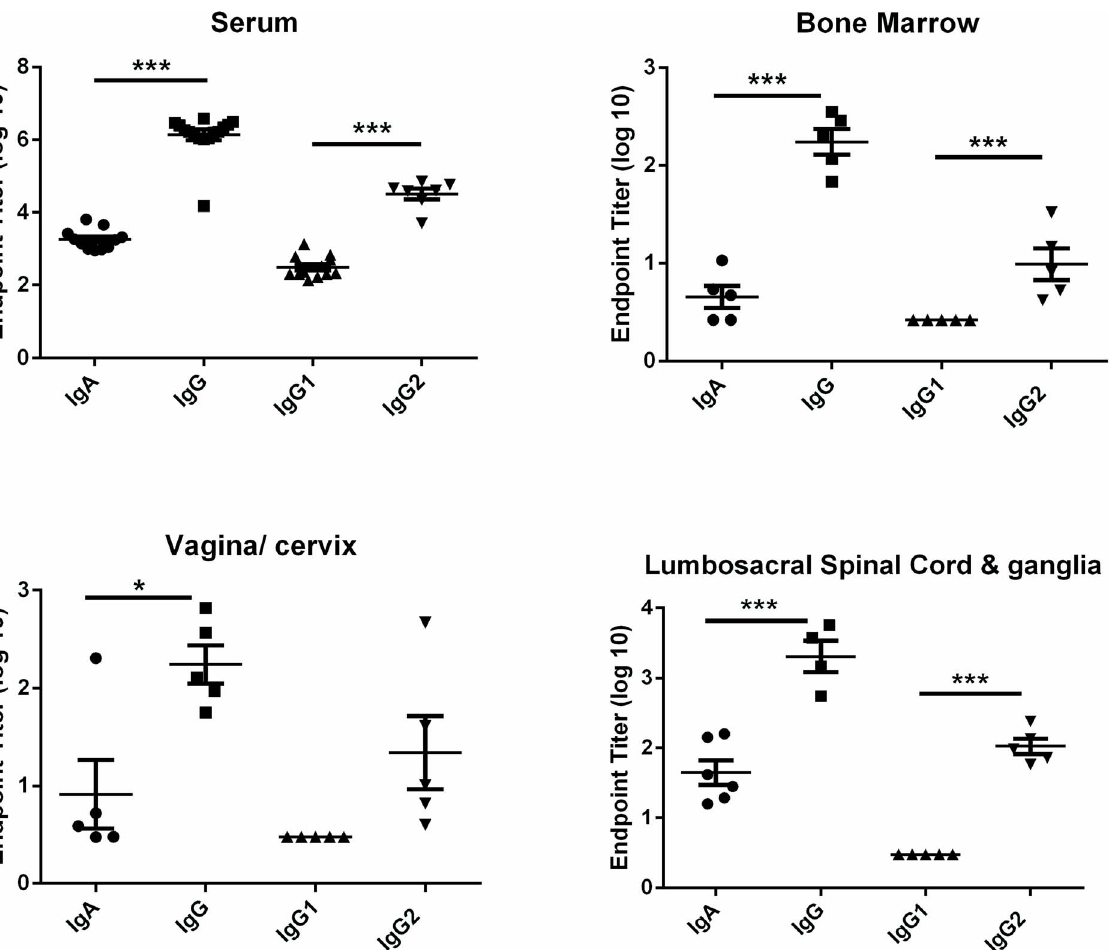
Fig. 3. Isotype and IgG subclass of HSV-specific antibodies produced by ASCs isolated from lymphoid tissue and non-lymphoid sites of HSV-2 infection. Hartley guinea pigs were infected ivag with HSV-2 strain MS, serum was collected and lymphocytes were isolated from the indicated tissues on days 48–57 post infection. Supernatants from ASC cultures were collected on day three after ASC isolation. The immunoglobulin isotype and IgG subclass of HSV-specific antibodies from serum and ASC supernatant were determined by ELISA. Each data point represents ASC supernatant from an individual animal. (* P , 0.05; *** P , 0.0001, Student’s t